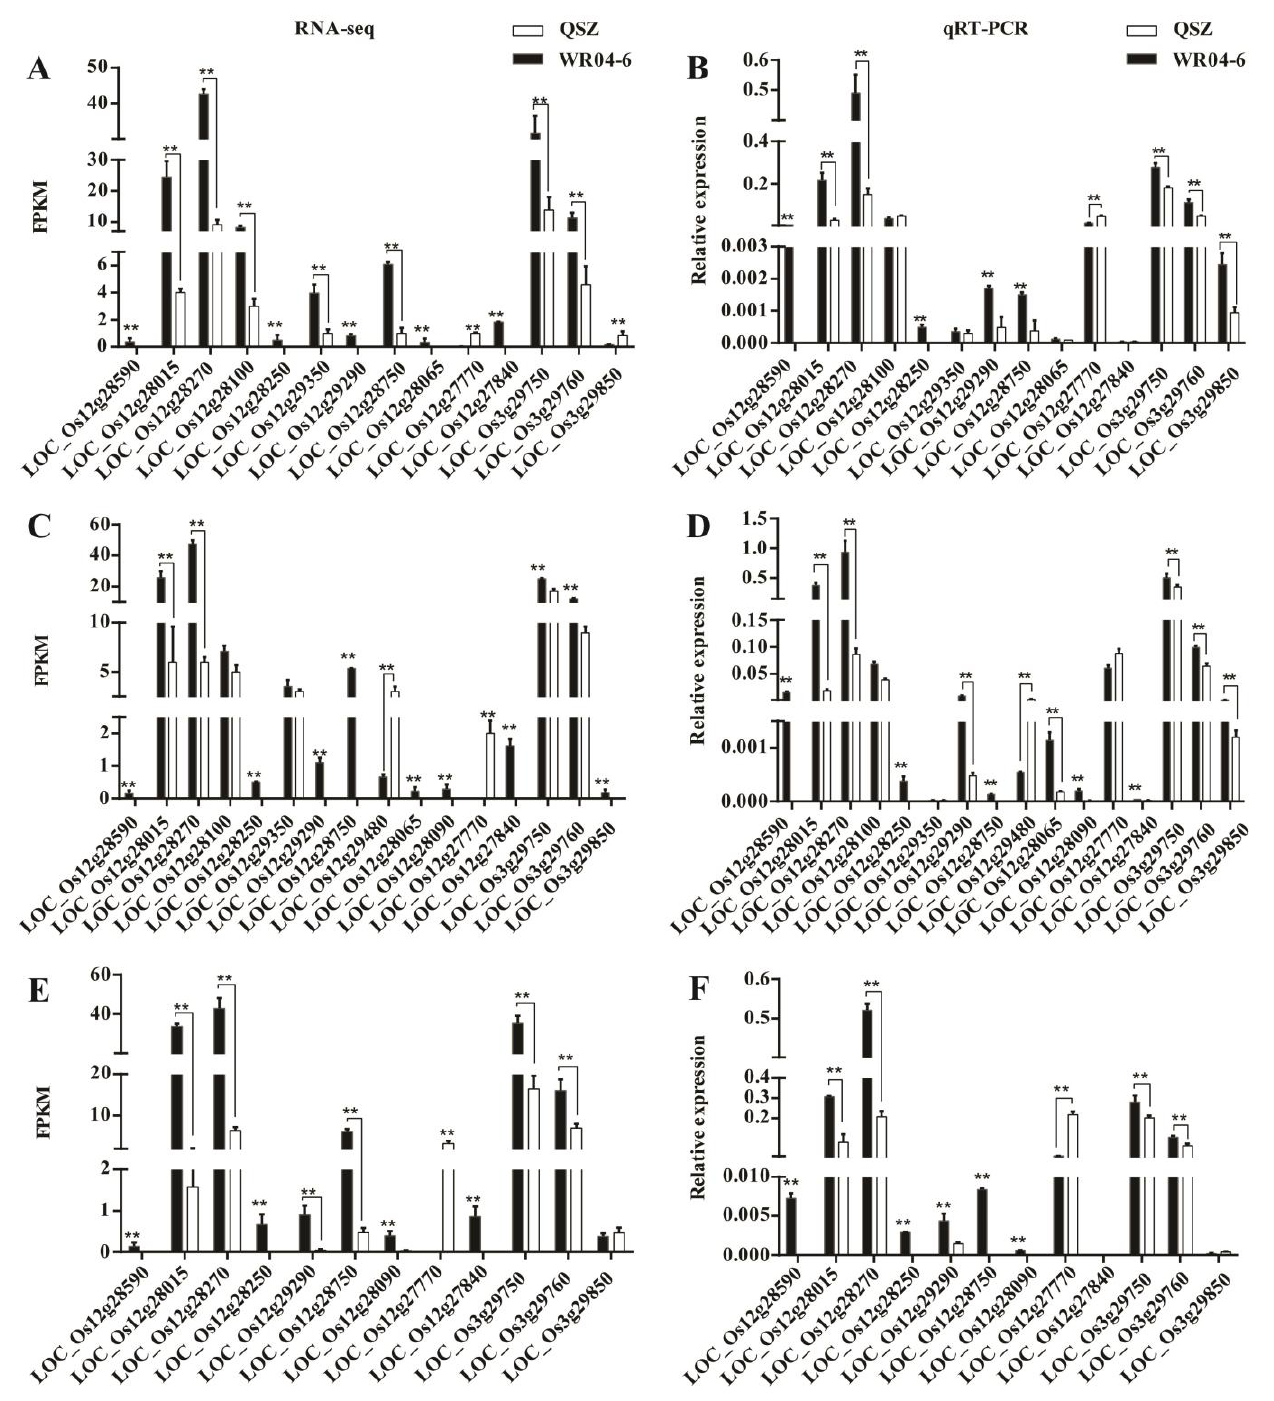
Figure 7. Expression level analysis of DEGs between WR04-6 and QSZ in the mapping intervals. ( A , B ) The expression level of DEGs at 10 °C for 10 DAI. ( C , D ) The expression level of DEGs at 10 °C for 12 DAI. ( E , F ) The expression level of DEGs at 10 °C for 14 DAI. Error bars represent SD ( n = 3). The statistical significance was determined via Student’s t -test. **, p ≤ 0.01.